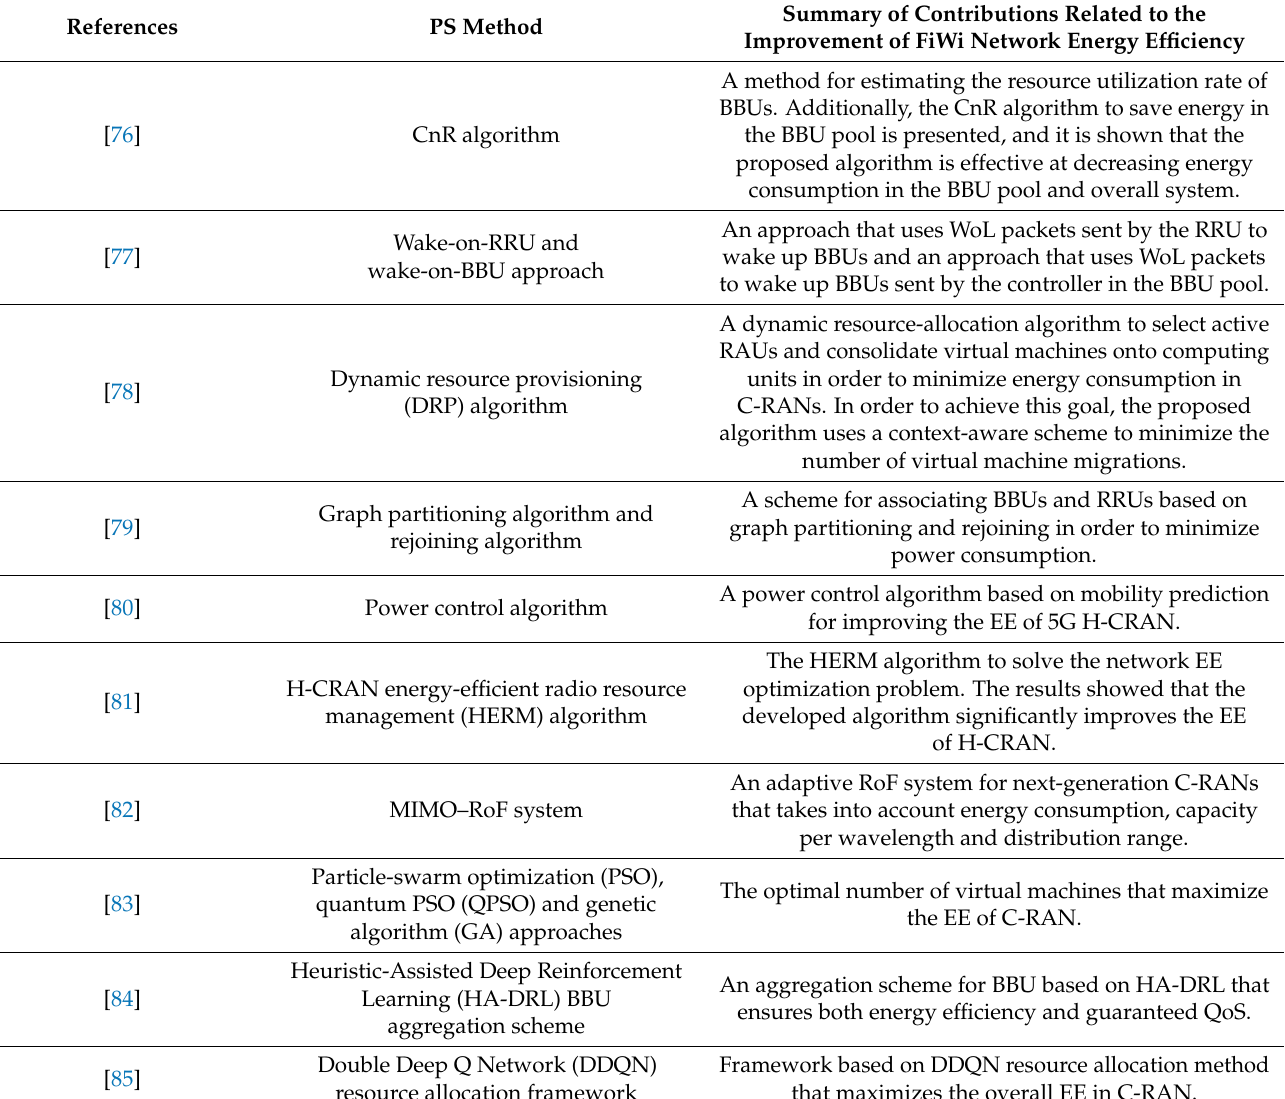
Table 3. Summary of the related works on PS methods in C-RAN